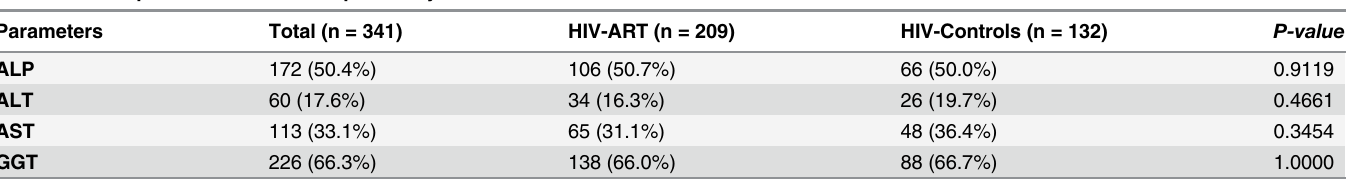
Table 3. Participants with elevated hepatic enzymes. Parameters